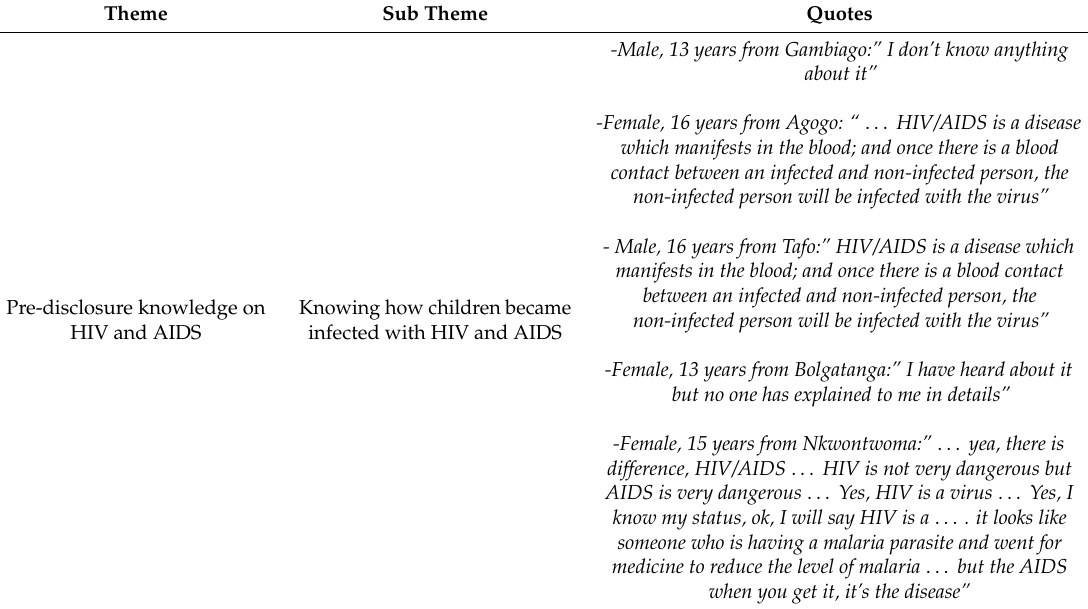
Table 2. Emerged themes and related